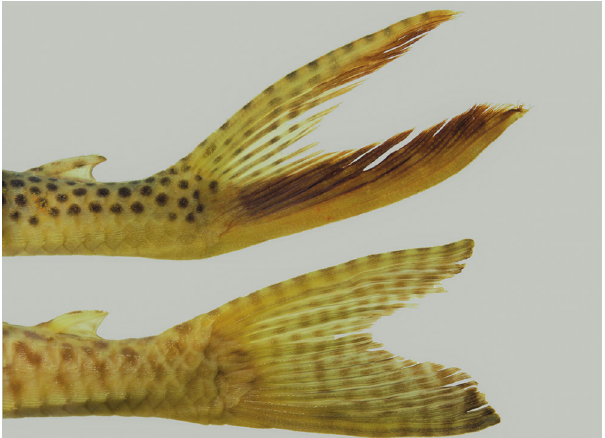
Fig. 5. Lateral view of caudal fin illustrating the coloration: Upper: Aphanotorulus rubrocauda MNRJ 39824, paratype, 132.2 mm SL. Lower: Aphanotorulus emarginatus INPA 36634, 147.3 mm